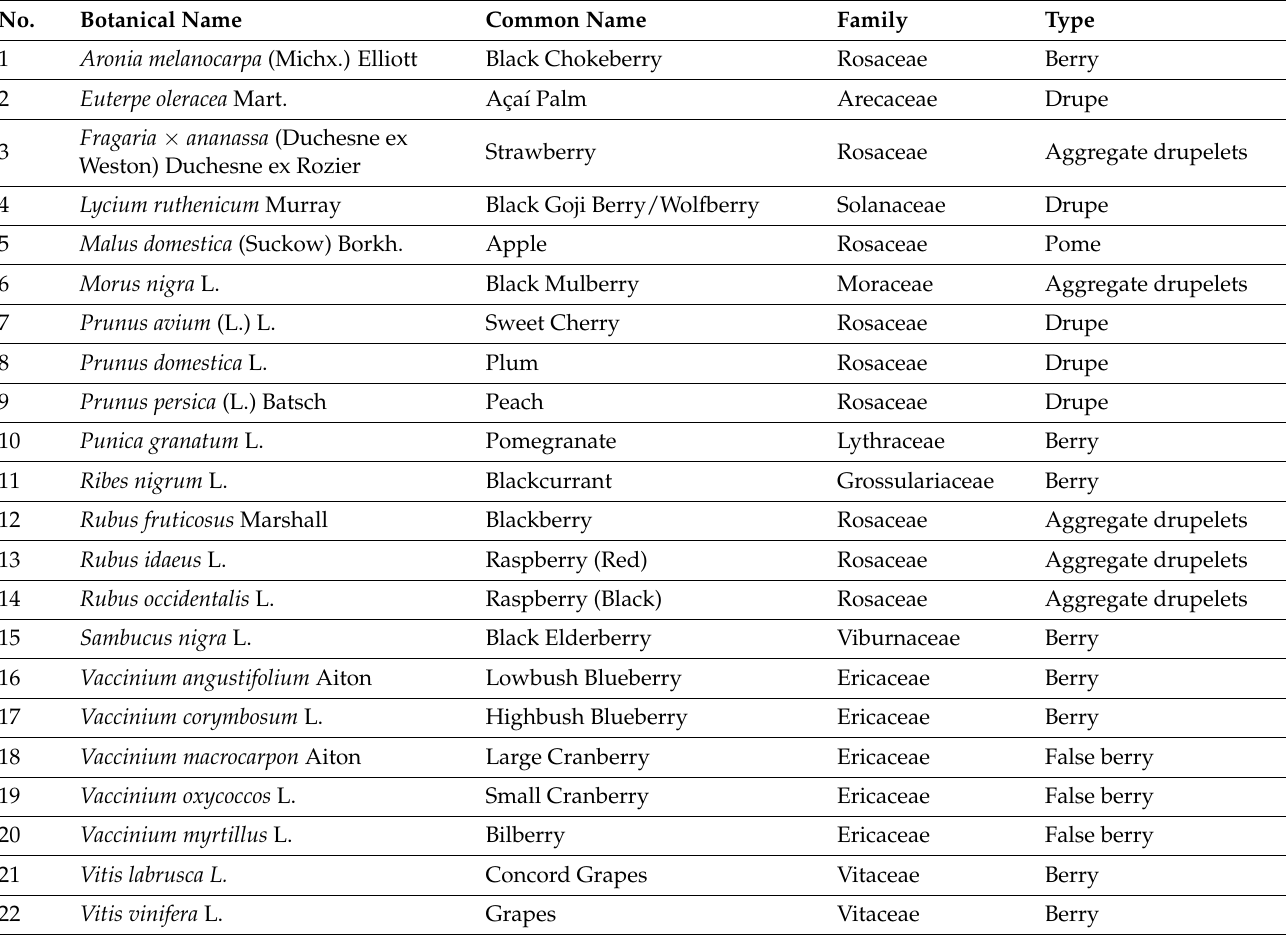
Table 1. List of anthocyanin-containing berries and